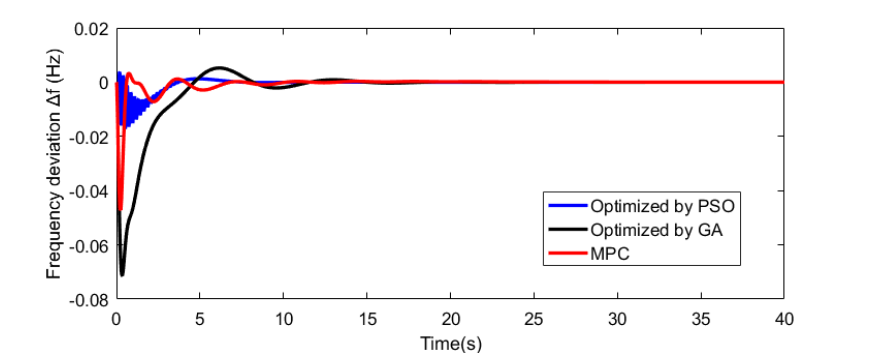
Figure 8. Frequency deviation in Area 2 for the first